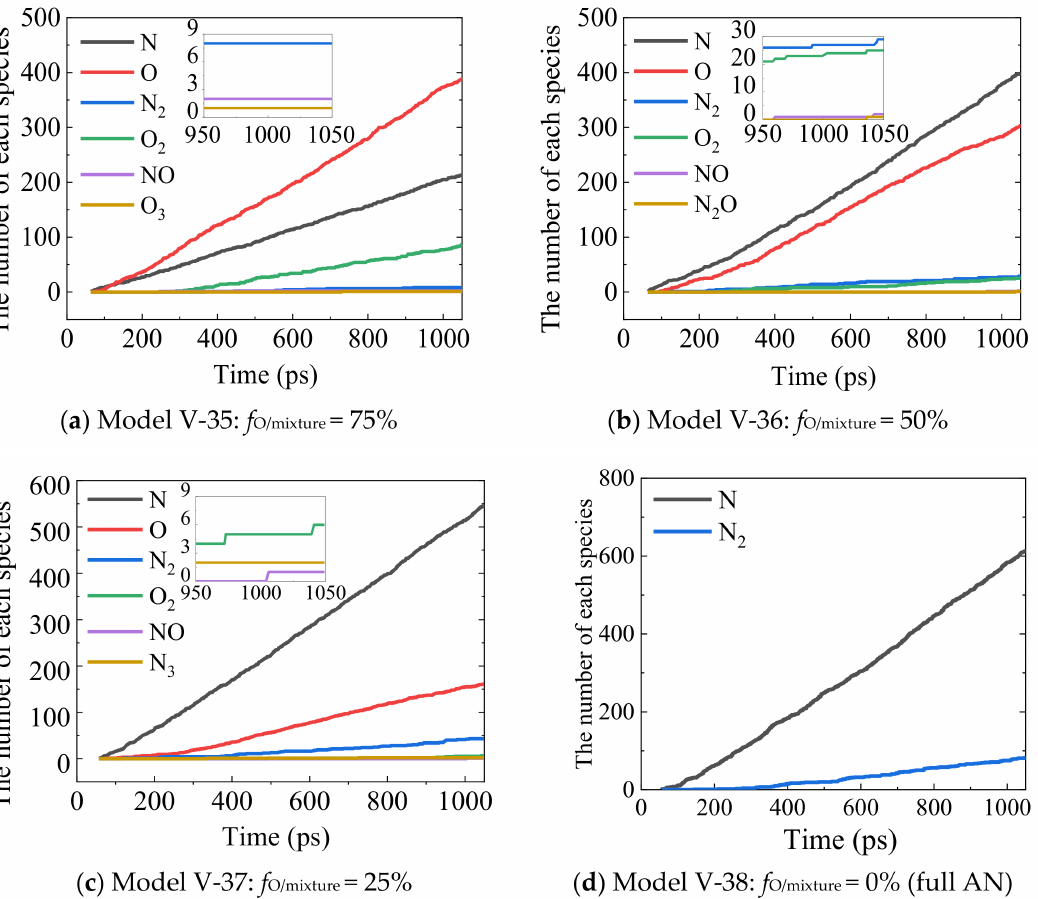
Figure 14. Surface catalytic reaction products. ( a ) Model V-35: f O/mixture = 75%, ( b ) Model V-36: f O/mixture = 50%, ( c ) Model V-37: f O/mixture = 25%, and ( d ) Model V-38: f O/mixture = 0% (full